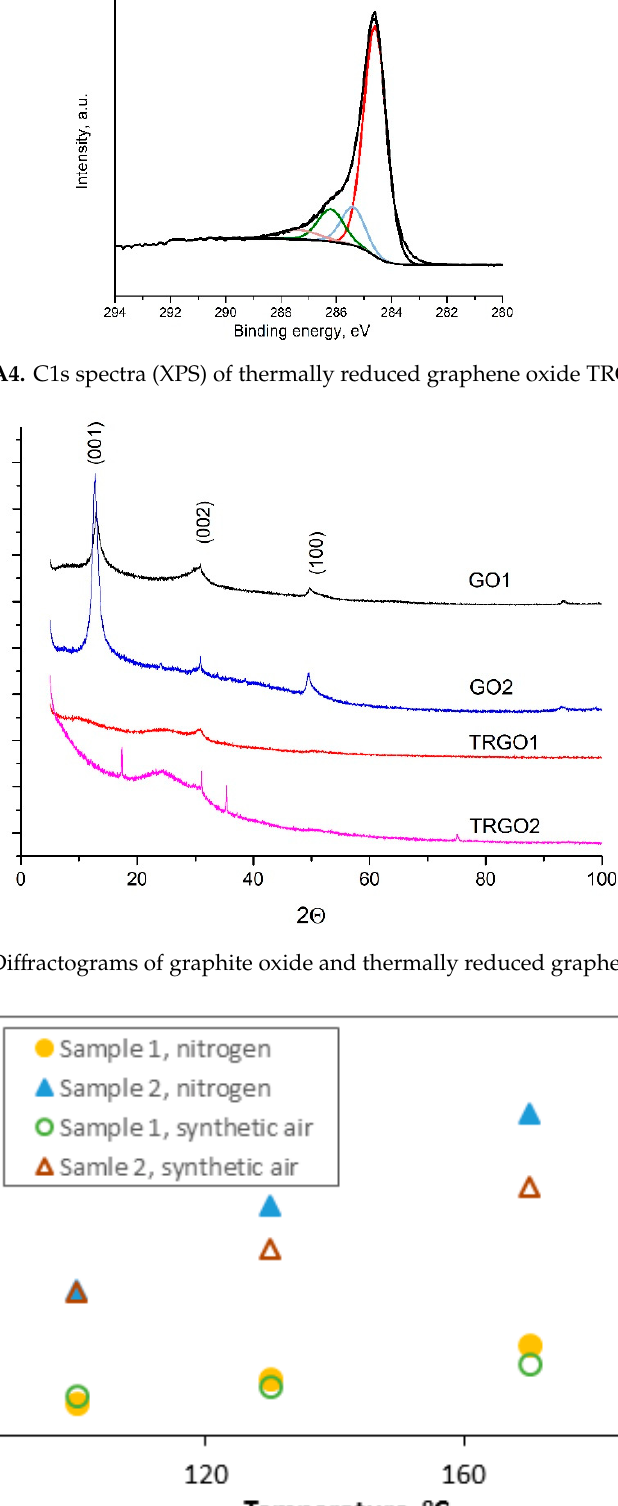
Figure A6. The response of Samples 1 and 2 affected by hydrogen in various temperatures.